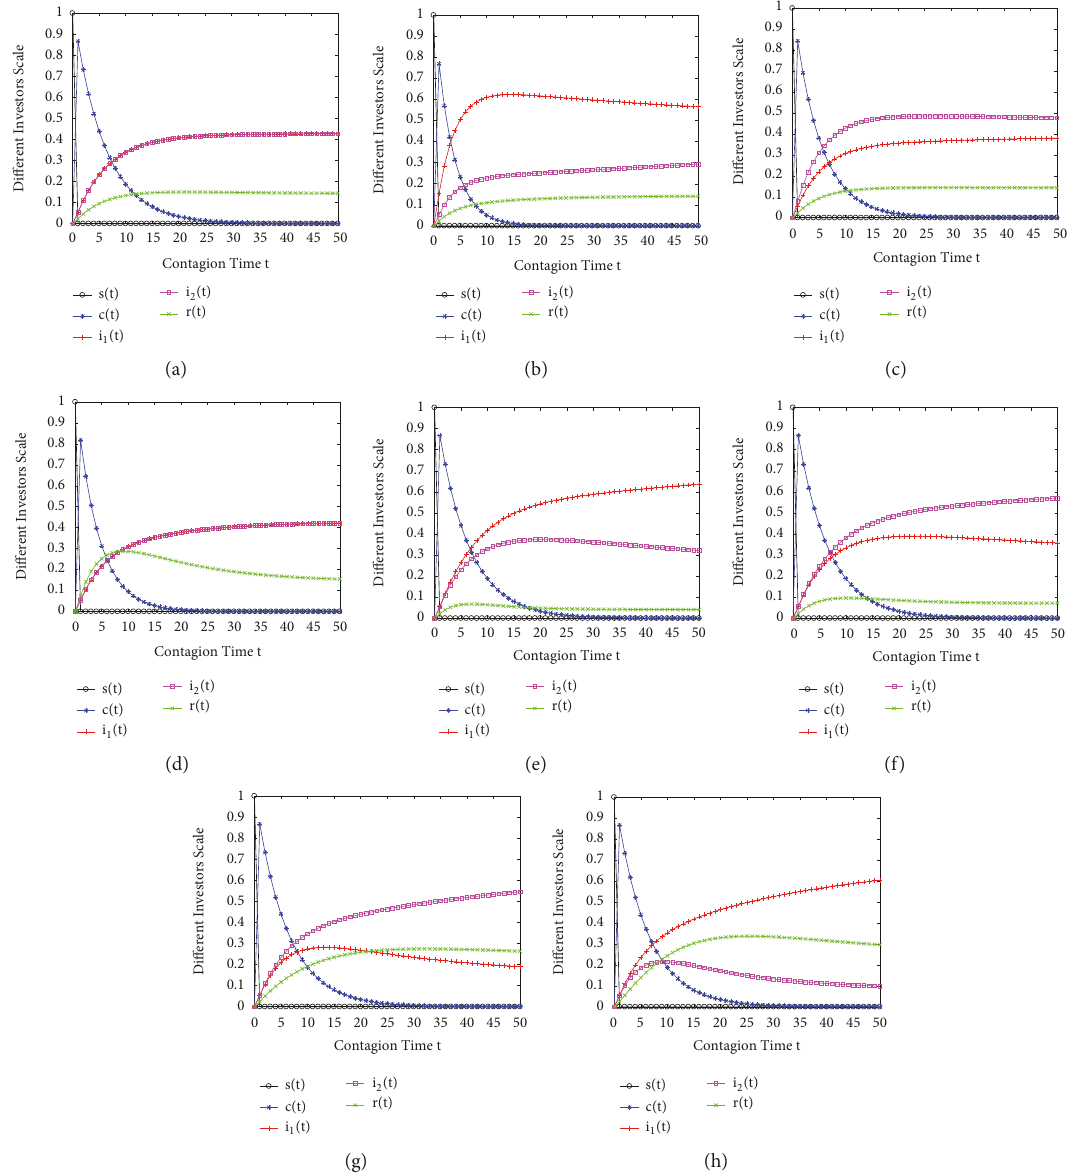
Figure 15: Investor scale trends of different states in SCI 1 I 2 R investor risk contagion model on bilayer-coupled networks in the stock market under different heterogeneous mechanism probability